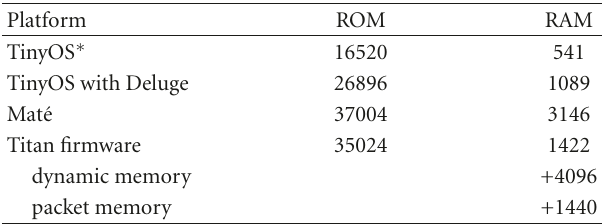
Table 1: Memory footprints (bytes) in the Tmote Sky sensor node. The Tmote Sky module provides 48 k ROM and 10 k RAM.